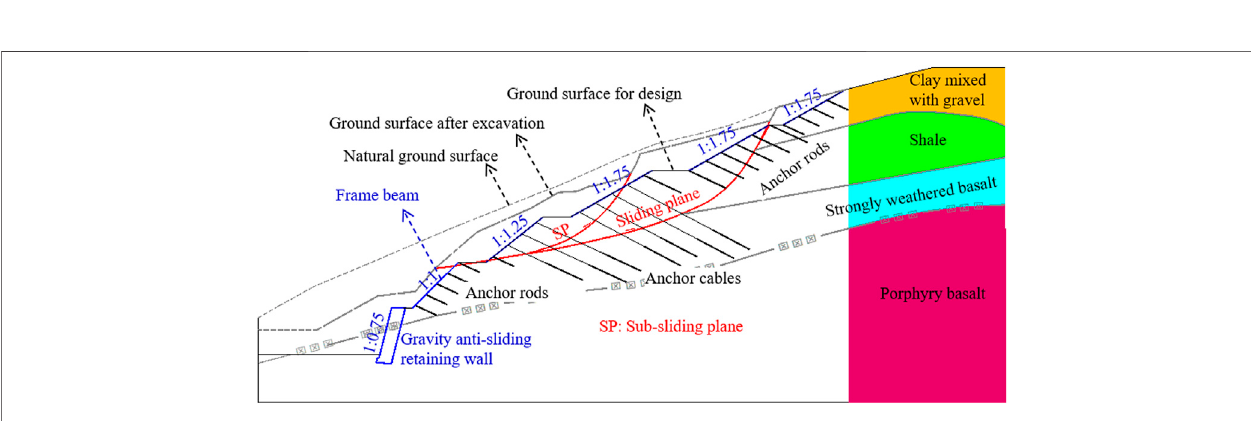
FIGURE 8 | Monitoring diagram of displacement of measuring points before and after applying the retaining wall. (O stands for the original state without supports, and the US stands for under support by gravity anti-sliding retaining well.). (A) : None-support, (B) : Gravity anti-sliding retaining wall supporting.